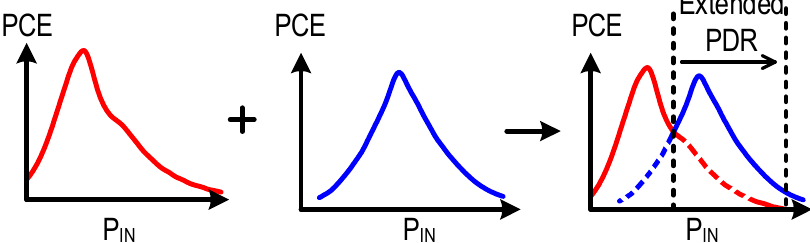
Figure 3. Conceptualization of the PCE curve on the proposed reconfigurable rectifier.